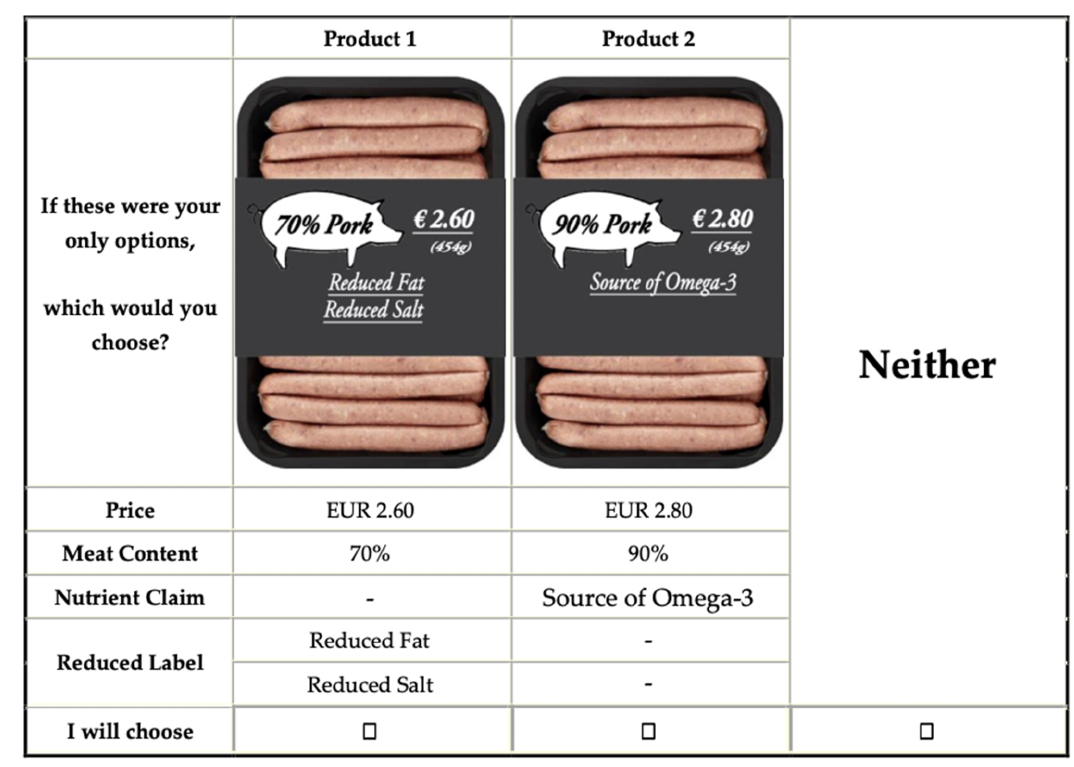
FigureA6. Choice set 6 in the questionnaire Foods 2022 , 11 , x FOR PEER REVIEW Figure A6. Choice set 6 in the questionnaire.